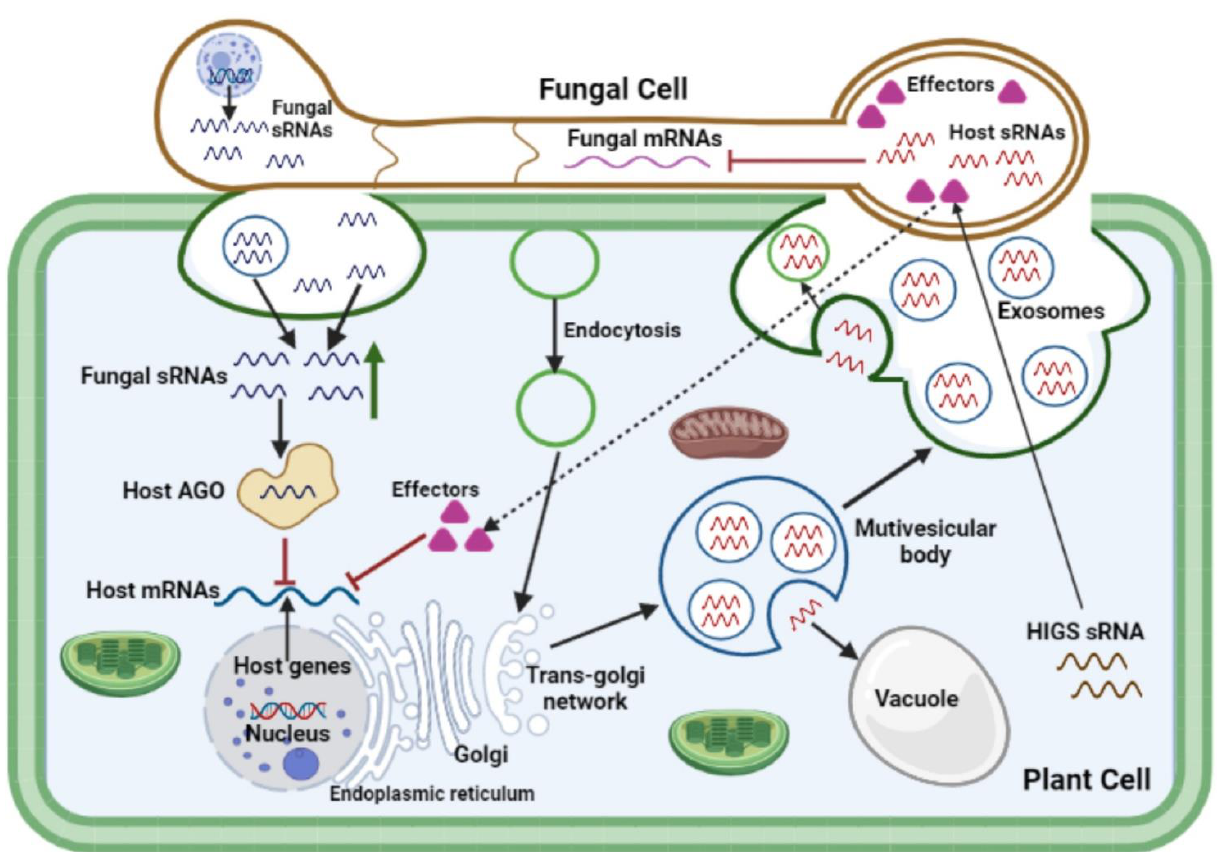
Figure 2. Cross-kingdom RNAi and vesicle trafficking during plant-fungal pathogen interactions. Fungal and plant sRNAs trigger cross-kingdom RNAi during plant-pathogen interactions. Fungal sRNAs translocate into plant cells and hijack the host plant Argonaute (AGO) protein of the RNAi machinery to suppress host plant immune response. The fungal sRNAs are upregulated upon infection (indicated by green arrow). Host cells also can deliver sRNAs into pathogen cell, either host induced gene silencing (HIGS) sRNAs or endogenous sRNAs, to target virulence genes and other essential pathogen genes. The generation of multivesicular bodies and release of exosomes at the site of pathogen invasion is part of the host penetration resistance pathway. Among other molecules, the putative exosomes contain sRNAs that can target vesicle trafficking components of the pathogen. Exosomes can also inhibit fungal growth and stall further ingress. The production of pathogen-derived sRNAs that may target and silence host genes can be inhibited by this form of host plant immunity. The fungal pathogens also secrete proteinaceous effectors through the haustorium into the host cells to suppress the host immunity genes, thereby causing disease. How fungal pathogens transport proteinaceous effectors and sRNAs into their host cells is still elusive. On the other hand, plants secrete extracellular vesicles to transport host sRNAs into pathogens to silence fungal genes involved in pathogenicity. Passage of host sRNAs through the haustorial cell wall, either active or passive, occurs and once inside the fungal haustorium the silencing molecules trigger RNAi of their mRNA targets, and may act as primers in the fungal silencing pathway, leading to the generation of systemic silencing signals. Cell structures are not drawn to scale.